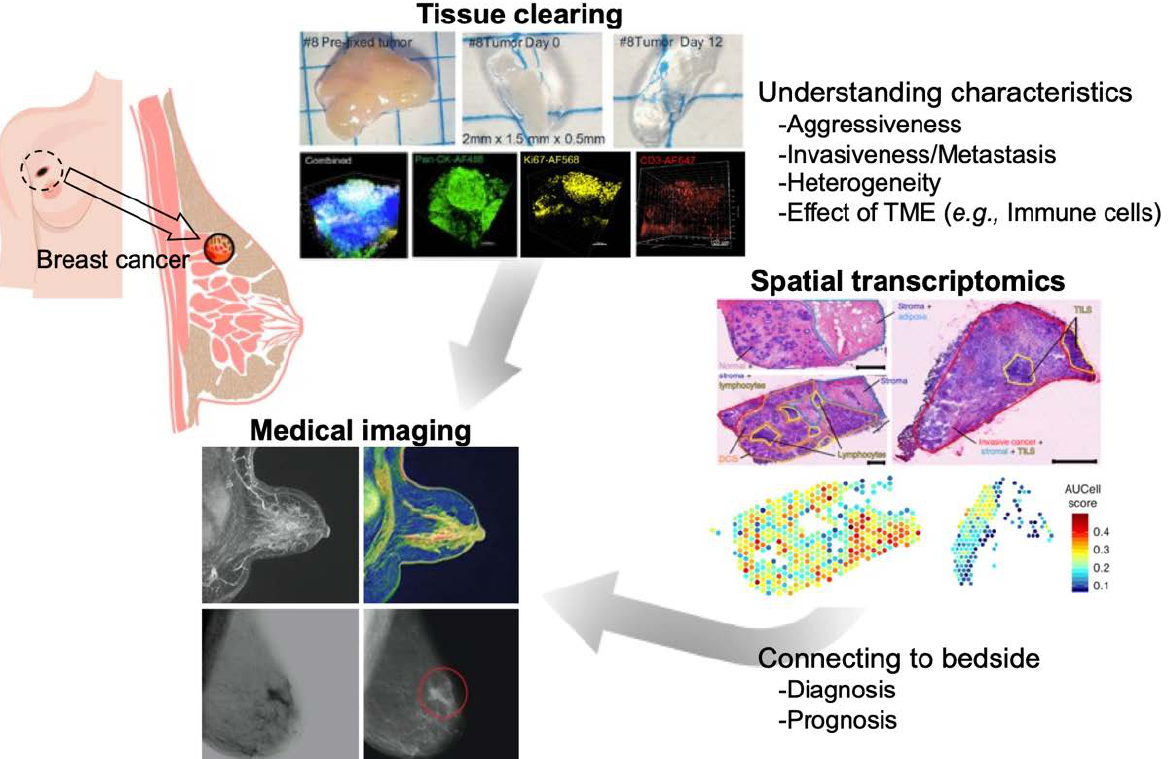
Figure 1. Spatial and high-resolution visualization using imaging techniques to understand breast cancer. Reprinted/adapted with permission from Refs. [16] (This article is an open access article distributed under the terms and conditions of the Creative Commons Attribution (CC BY) li- cense (https://creativecommons.org/licenses/by/4.0/)) and [17], Copyright© 2022, Springer Nature America,